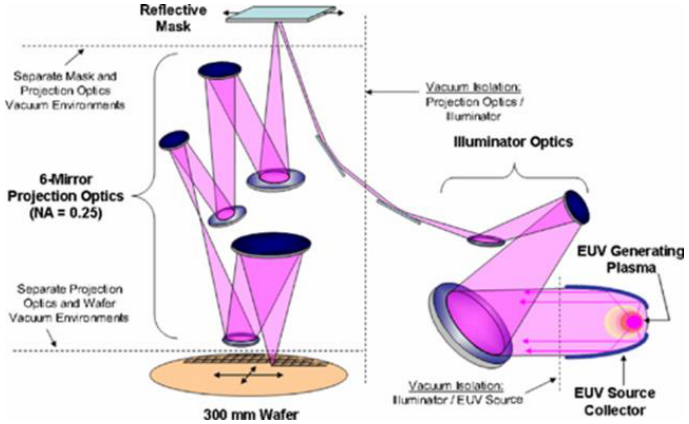
Figure 1. Technology node scaling is driven by the development of lithography. EUV will lead the industry in the next decade. Reprinted from [7], courtesy of IMEC. Lately, the resolution has been enhanced by substituting the deep ultraviolet (DUV) wafer scanners with novel devices that use soft X-ray radiation, also called extreme ultra- violet (EUV) radiation at λ = 13.5 nm [5]. A further reduction in the working wavelength to 6.7 nm and the use of beyond extreme ultraviolet (BEUV) radiation will boost the per- formance of microprocessors even more [5,9]. Significant efforts were directed into this direction by ASML, which is the world’s largest manufacturer of DUV and EUV litho- graphical equipment [10–14]. Soft X-rays exhibit a higher degree of absorption in all materials, which has necessi- tated the use of reflective optics. Thus, the reflectivity of X-ray optics is crucial for the efficiency of lithographical stepper machines. Figure 2 illustrates the optical system of the typical stepper machine used in lithography [15]. As can be seen, it contains at least three mirrors in the illuminator optics and six mirrors in the projection optics sections. The overall reflectivity of such an optical system is approximately one hundred-fold lower than the reflectivity of a single mirror due to the multiple reflections [16,17]. Increasing each mirror’s reflectivity from 53 to 65% will increase the integral throughput of the system approximately seven-fold. Thus, even a minimal improvement in reflectivity gives an immediate boost to the performance of lithographical systems, which includes the spatial resolution, EUV light intensity, and speed. In addition, it reduces the overall production cost by decreasing the exposition time. Figure 2. Schematics of the optical system of a lithographical stepper machine. Reprinted from [15]. The weak reflection of soft X-ray radiation by solids demands advanced reflective optical equipment. Immediately after the discovery of X-rays, it was stated that the refrac- tive index of all materials is very small ( ∼ 10 −5 ) [18]. Later, by discovering X-ray diffraction